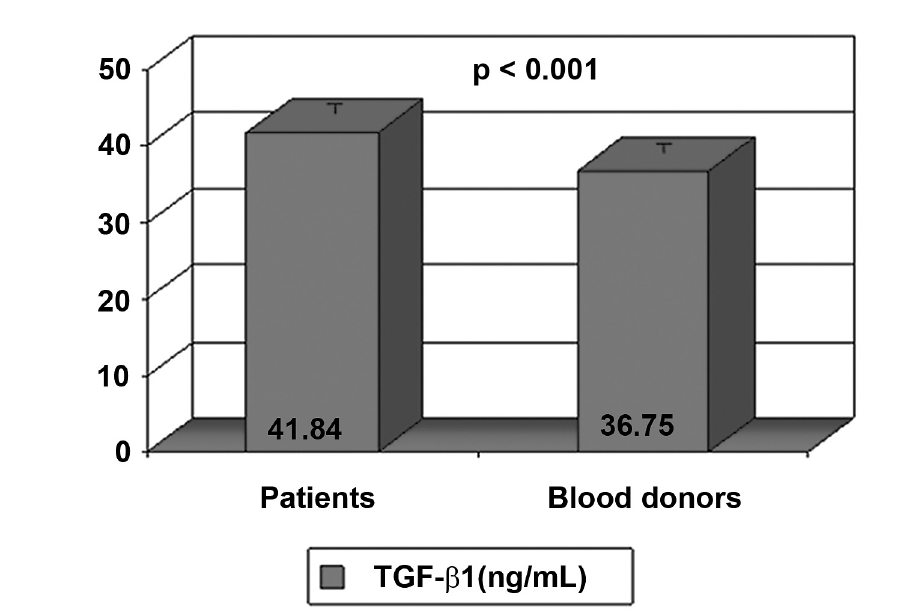
Figure 1 – TGF-β1 serum levels in PD patients and healthy blood donors.